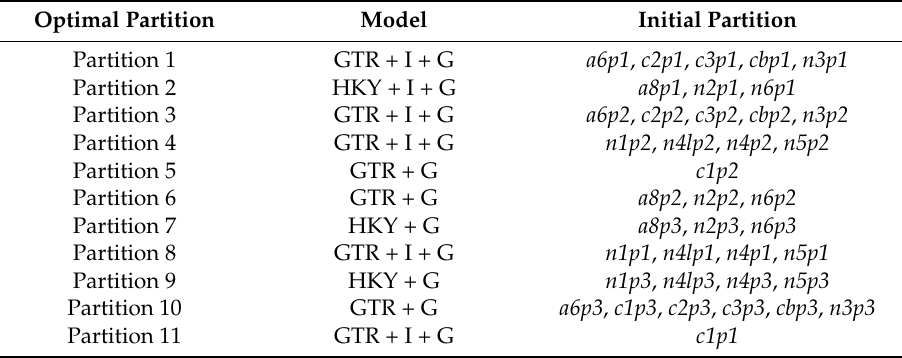
Table 5. The best schemes of partition and substitution models of 13 protein-coding genes in 22 species of